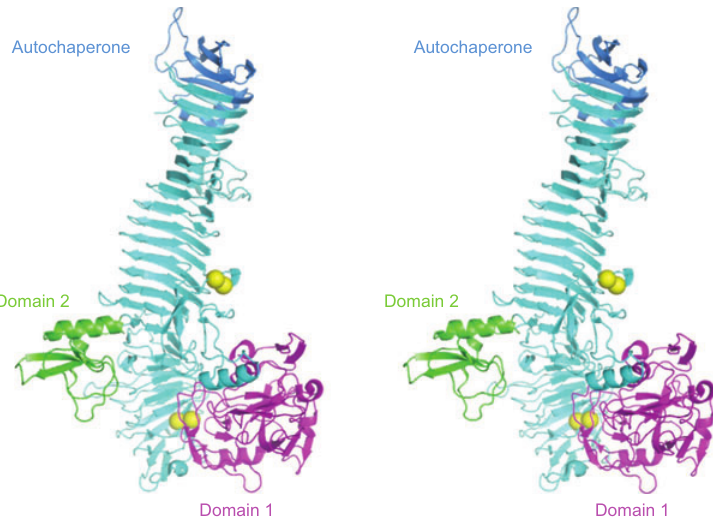
Figure 6 Stereo view of the 1048-residue passenger domain of the serine protease autotransporter Hbp. The serine protease domain (domain 1, residues 1 – 256 of the mature passenger) is shown in pink, a side domain of unknown function (residues 481 – 556) in green, and the AC region (residues 950 – 1048) in blue. Yellow spheres indicate the positions of cysteine pairs introduced into the protein (110 – 348 and 707 – 712) to test for ability to secrete under oxidising conditions. Only the lower cysteine pair, cross-linking domain 1 to the β -helix, impairs secretion. The model shown is PDB entry 1WXR (54) .